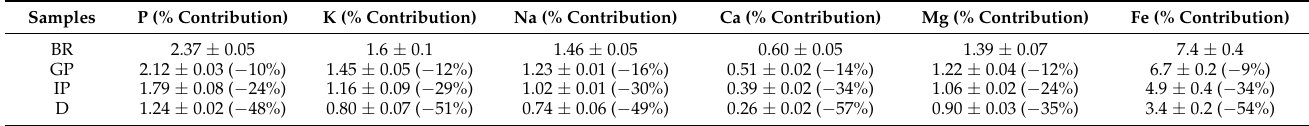
Table 2. Contribution of the beetroot sample (BR) for the dietary reference intakes (DRI) of mineral elements, and also the contribution of the gastric phase (GP), intestinal phase (IP) and digested (D) samples (average per 100 g portion). For each element, the percentage decrease in contribution compared to the undigested sample (BR) is shown in